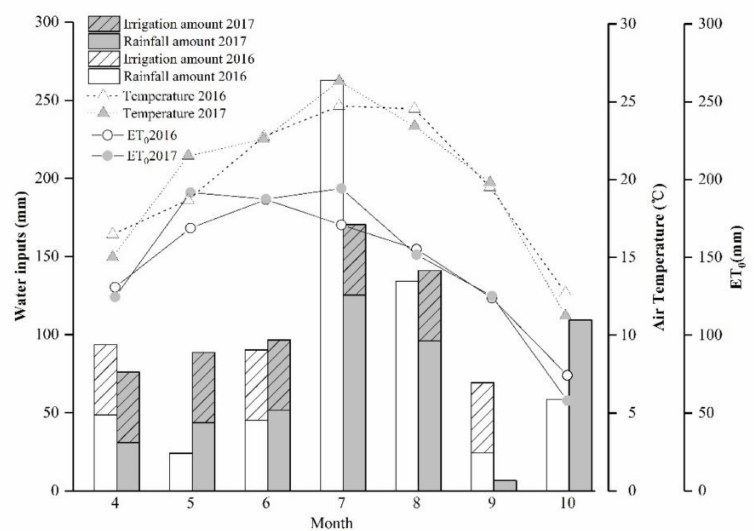
Figure 1. The precipitation, irrigation, air temperature, and reference evapotranspiration (ET 0 ) of the apple orchard during the growth seasons of 2016 and